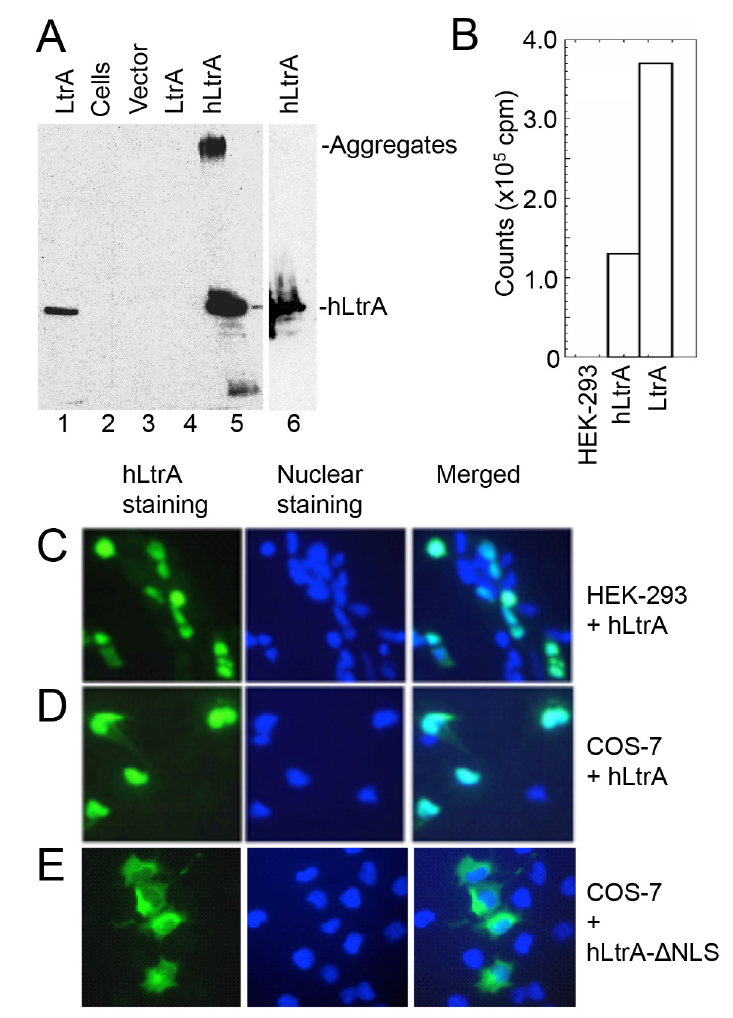
Fig 2. Human codon-optimized LtrA protein (hLtrA) with an SV40-NLS expressed in human cells has reverse transcriptase activity and localizes to the nucleus. (A) Immunoblots showing expression of codon-optimized hLtrA or non-codon optimized LtrA in transiently transfected HEK-293 cells after 48 h. After dissolving cells in SDS-containing gel loading buffer and boiling for 5 min, insoluble material was pelleted in a microfuge and the supernatant was loaded on the gel: Lanes: (1) LtrA purified from E . coli ; (2) untransfected cells; (3) cells transfected with empty vector (pKSBluescript); (4) cells transfected with pLtrA expressing wild- type LtrA with non-optimized codons; (5) cells transfected with phLtrA1 expressing human codon-optimized hLtrA. (6) Insoluble material from cells transfected with phLtrA1 resuspended in SDS-containing gel loading buffer and boiled for an additional 5 min to dissolve aggregated hLtrA. (B) Reverse transcriptase assay. RT activity in nuclear lysates from HEK-293 cells, HEK-293 cells transfected with phLtrA1, and purified bacterially-expressed LtrA protein was assayed with a substrate comprised of a 0.9-kb Ll.LtrB- Δ ORF RNA and flanking exons with a DNA primer (E2+10) annealed to the downstream exon [47]. (C-E) Immunofluorescence assay of hLtrA localization in HEK-293 and COS-7 cells. The assay was done by using an anti-LtrA antibody with a secondary antibody conjugated with fluorescein isothiocyanate (FITC) at 48 h after transfection of phLtrA1 or phLtrA1- Δ NLS. Left panels, hLtrA immunofluorescence; middle panels, nuclei stained with Hoechst dye; right panels, merge of left and middle panels. plasmids that use a CMV (Pol II) promoter to express blue fluorescent protein (BFP) with or without the Ll.LtrB- Δ ORF intron and short flanking exon sequences (E1 and E2) inserted directly after the BFP start codon (Fig 3A). We transfected the plasmids into HeLa cells that